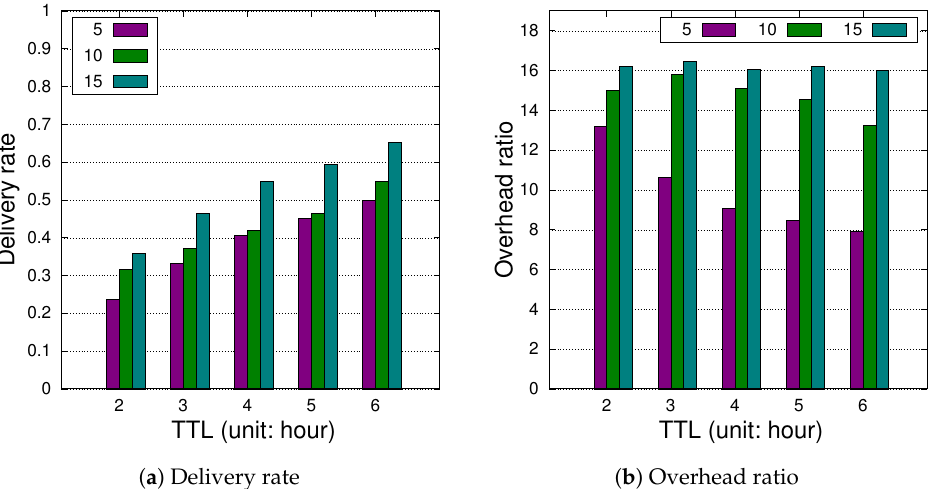
Figure 7. Results by MPMF with different values of L and TTL under TVCM trace (buffer size = 10